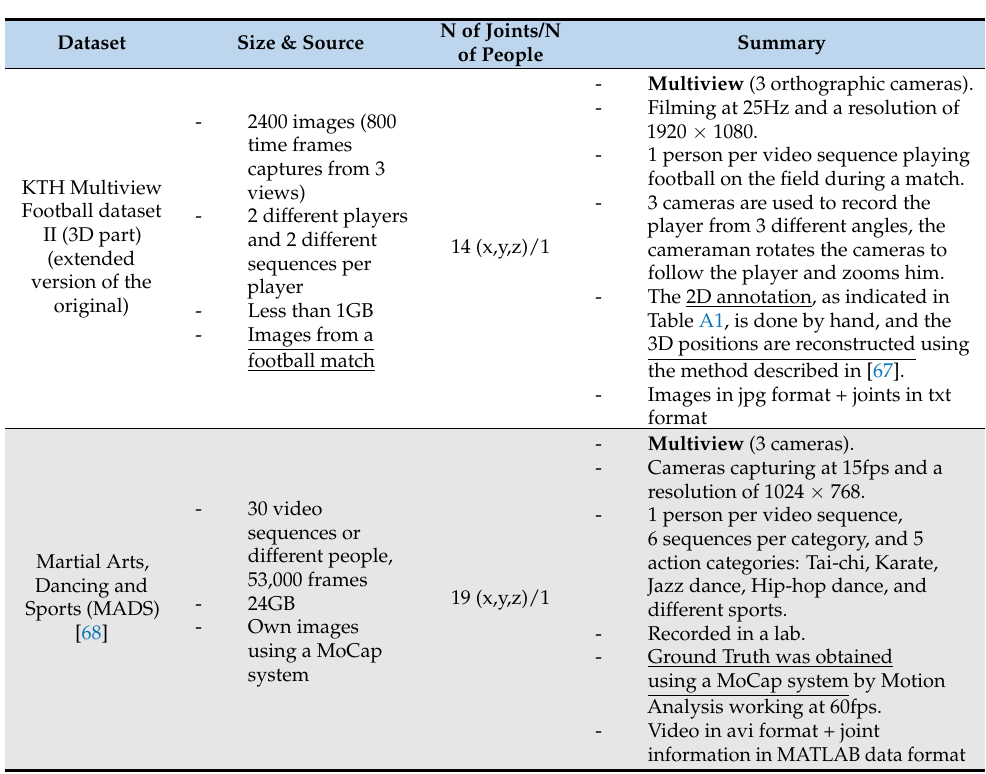
Table A2. 3D Evaluation Datasets.